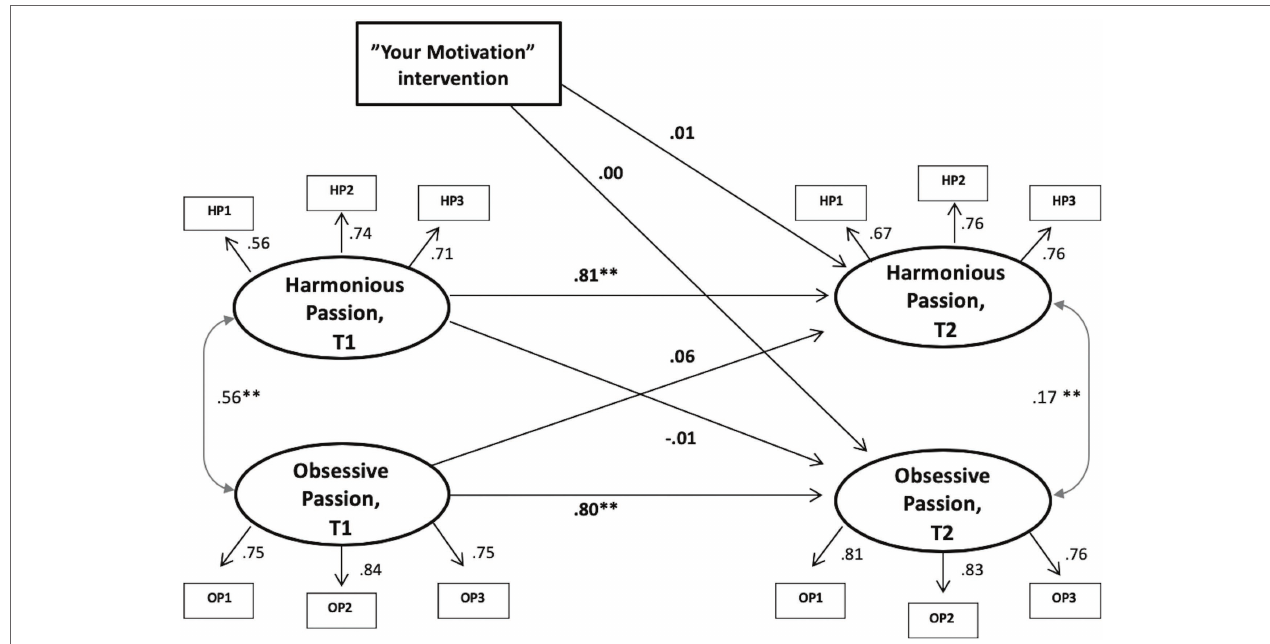
FIGURE 1 | Structural equation modeling of the results. The two passion constructs and the intervention variable. Note: ** p < 0.01; Intervention variable: Intervention group = 1, Control group =